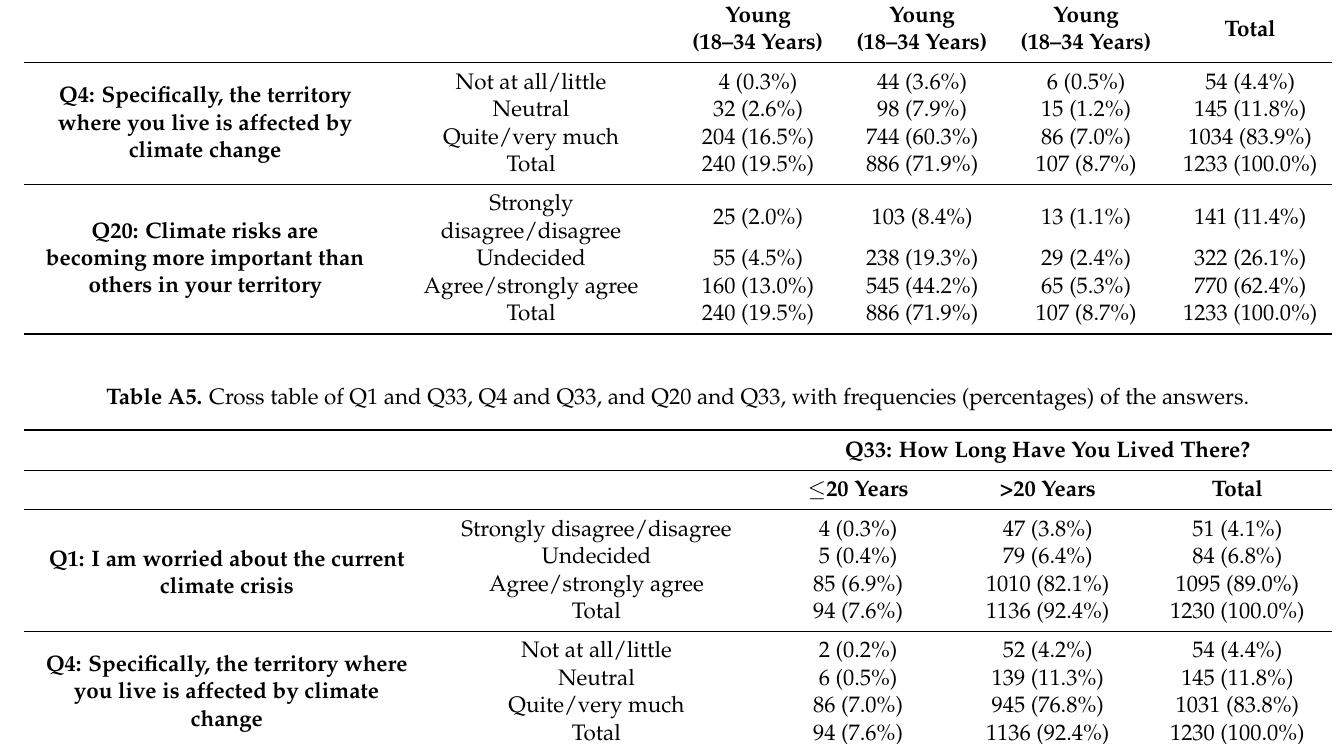
Table A4. Cross table of Q4 and Q31, and Q20 and Q31, with frequencies (percentages) of the answers.